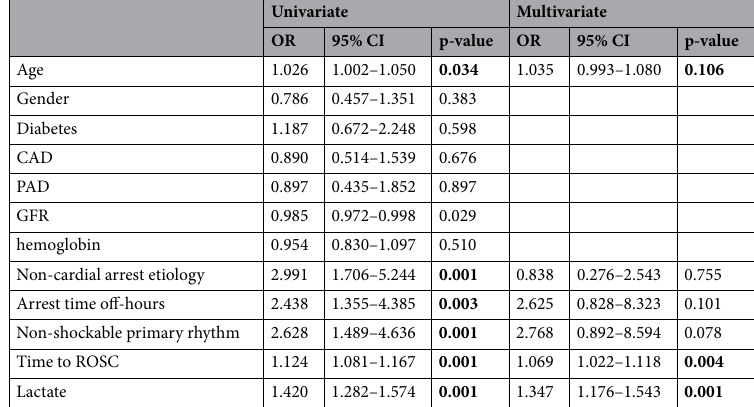
Table 3. LaG group: Regression analysis for hospital mortality after IHCA. Significant values are in bold. IHCA in-hospital cardiac arrest, LaG load-and-go, SaT stay-and-treat, IHCA intra-hospital cardiac arrest, OR odds ratio, CI confidence interval, GFR glomerular fraction rate, CPR cardiopulmonary resuscitation, CAD coronary artery disease, PAD peripheral arterial disease, ROSC return of spontaneous circulation.